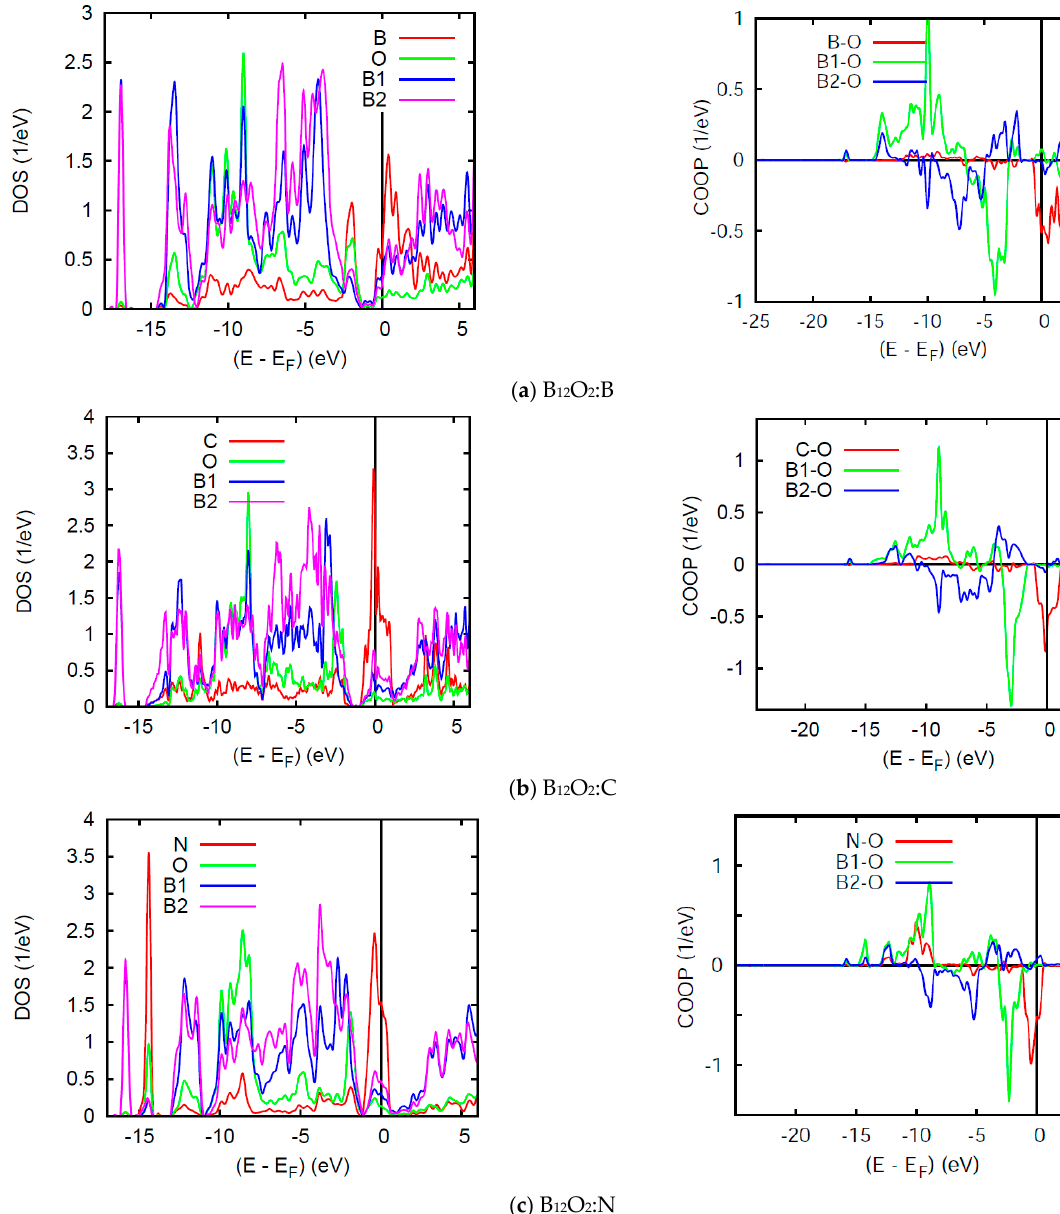
Figure 6. (color). B 12 O 2 :X. Site projected DOS (left) and chemical bonding from the COOP criterion (right) for ( a ) X = B; ( b ) X = C, and ( c ) X = N.